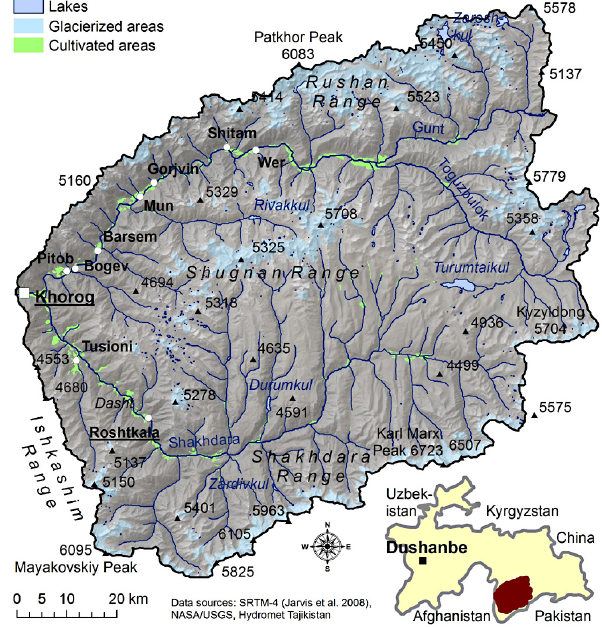
Fig. 1. The study